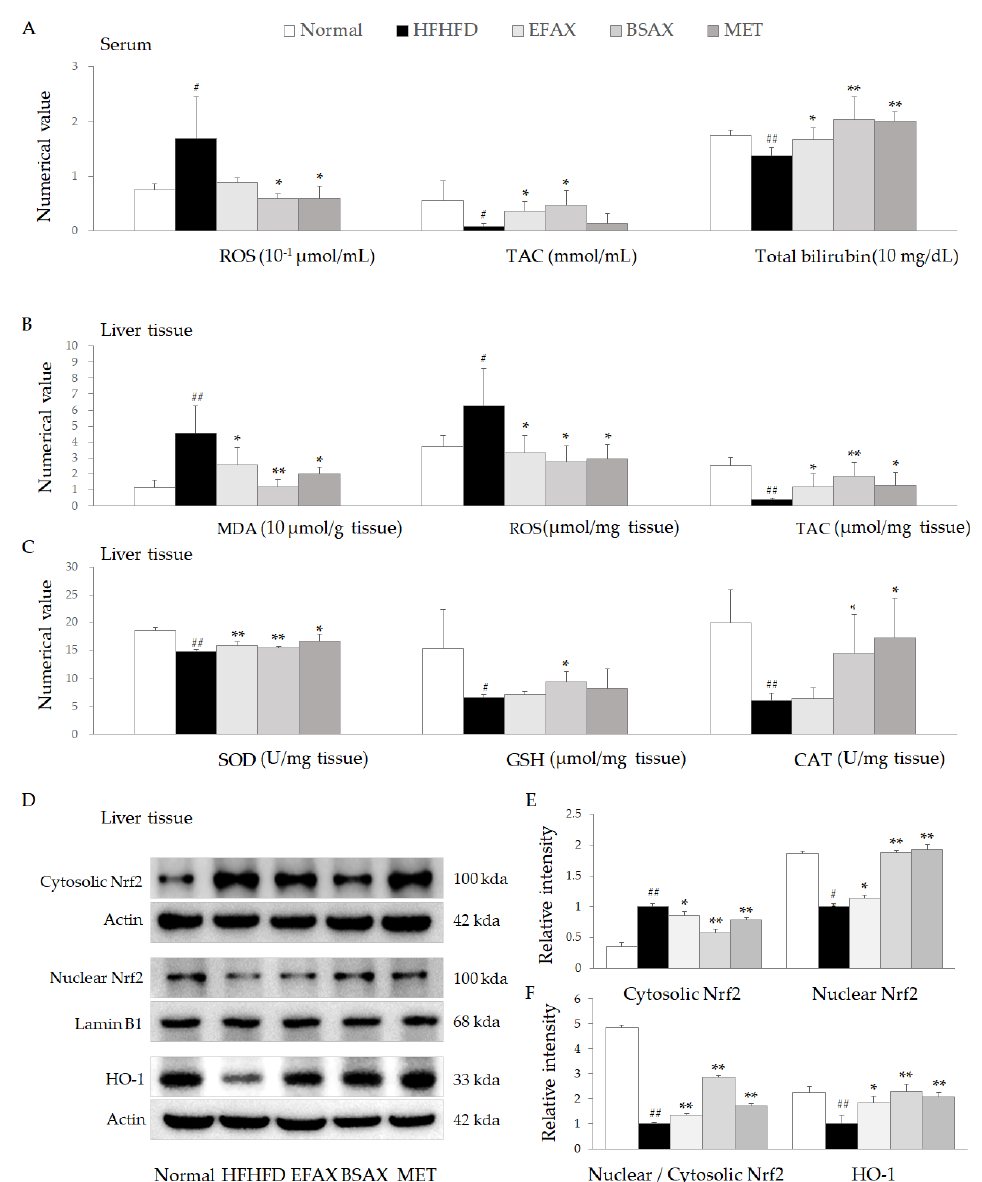
Figure 4. BSAX attenuated systemic and hepatic oxidative stress through the restoration of antioxi- dant capacity. ( A ) The levels of ROS, TAC, and total bilirubin in sera were determined according to the appropriate methods. ( B , C ) The levels of hepatic MDA, ROS, TAC, and the main antioxidative parameters (SOD, GSH, CAT) were also evaluated for comparison. ( D ) The levels of oxidative stress regulator-related proteins in hepatic tissue were detected by Western blotting. ( E , F ) ImageJ v1.8.0 was used for quantification of the relative intensities of the bands. # p < 0.05, ## p < 0.01, compared with the normal group; * p < 0.05, ** p < 0.01, compared with the HFHFD control. ROS, reactive oxygen species; TAC, total antioxidant capacity; MDA, malondialdehyde; SOD, superoxide dismutase; GSH, glutathione; CAT,